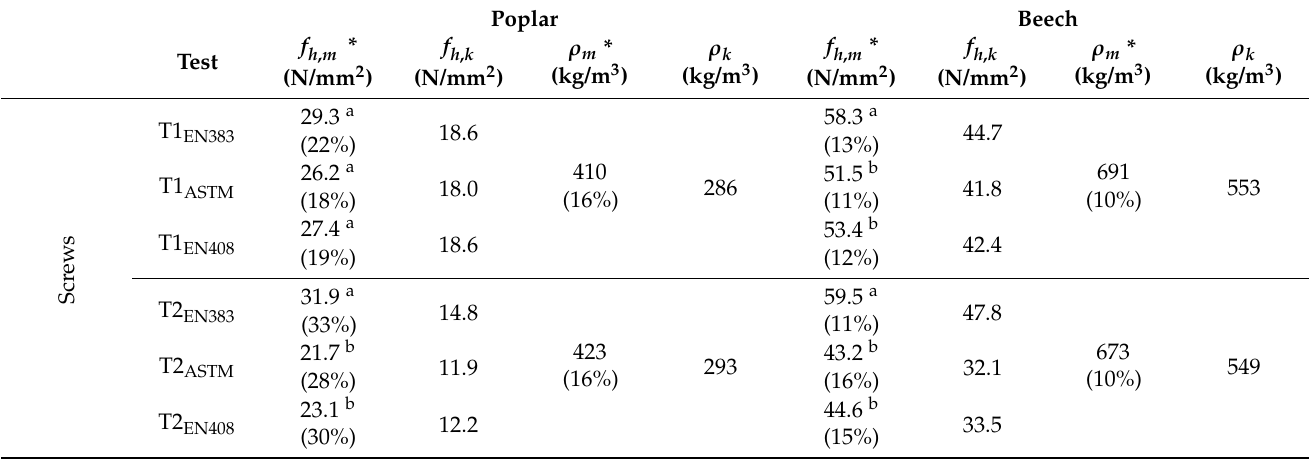
Table 2. Results of experimental